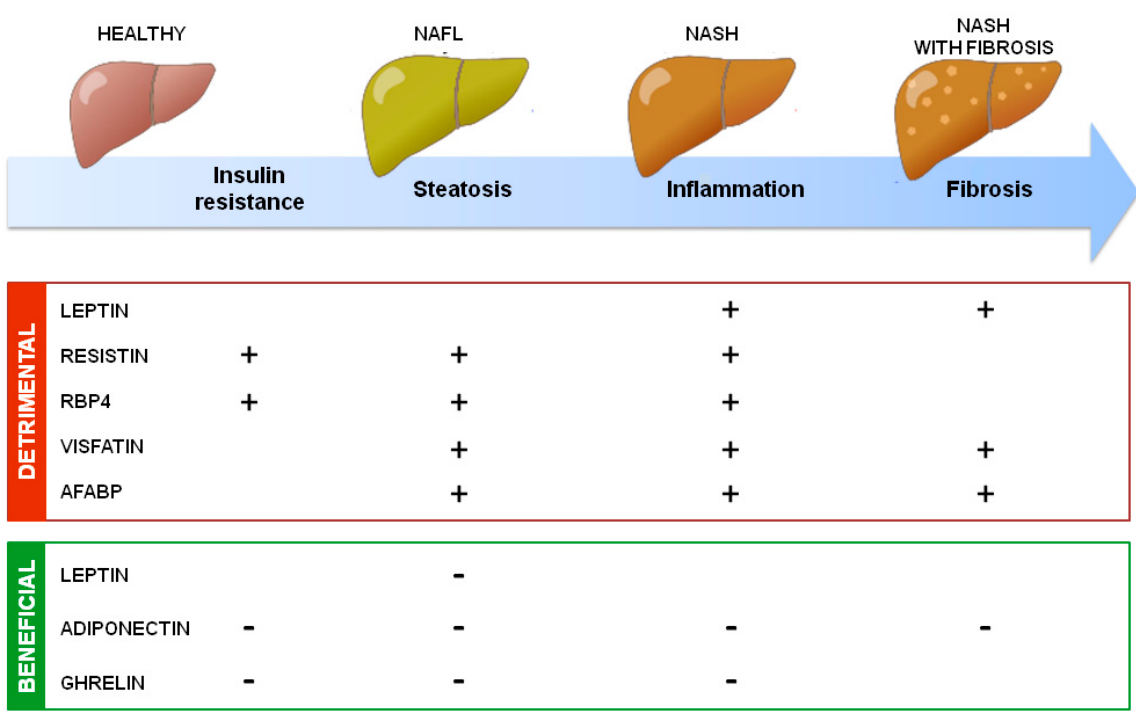
Figure 2. Summary of adipokines’ action in NAFLD development . Adipokines secreted by adipose tissue could have detrimental or beneficial effects on NAFLD development through, respectively, increasing (+) or decreasing ( − ) insulin resistance, hepatic steatosis, inflammation, and fibro- sis.